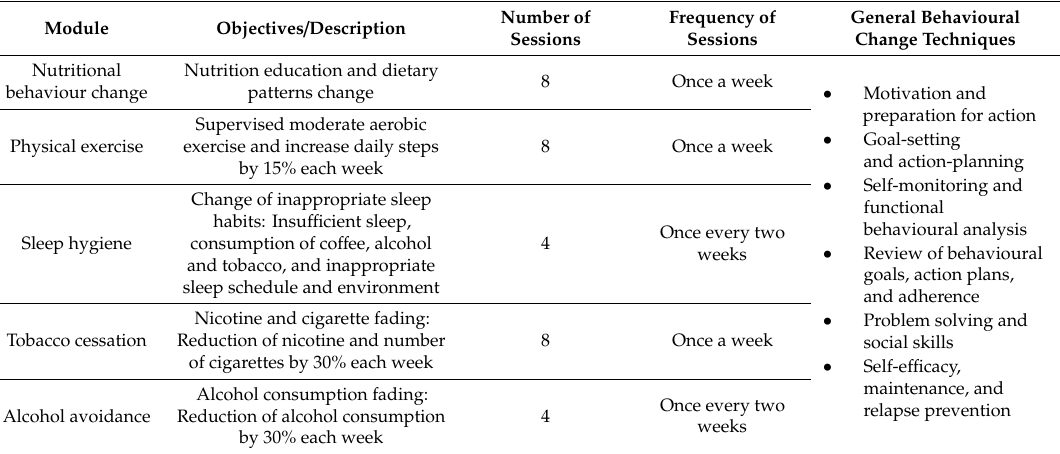
Table 3. Description and timing of the INTERAPNEA intervention modules and